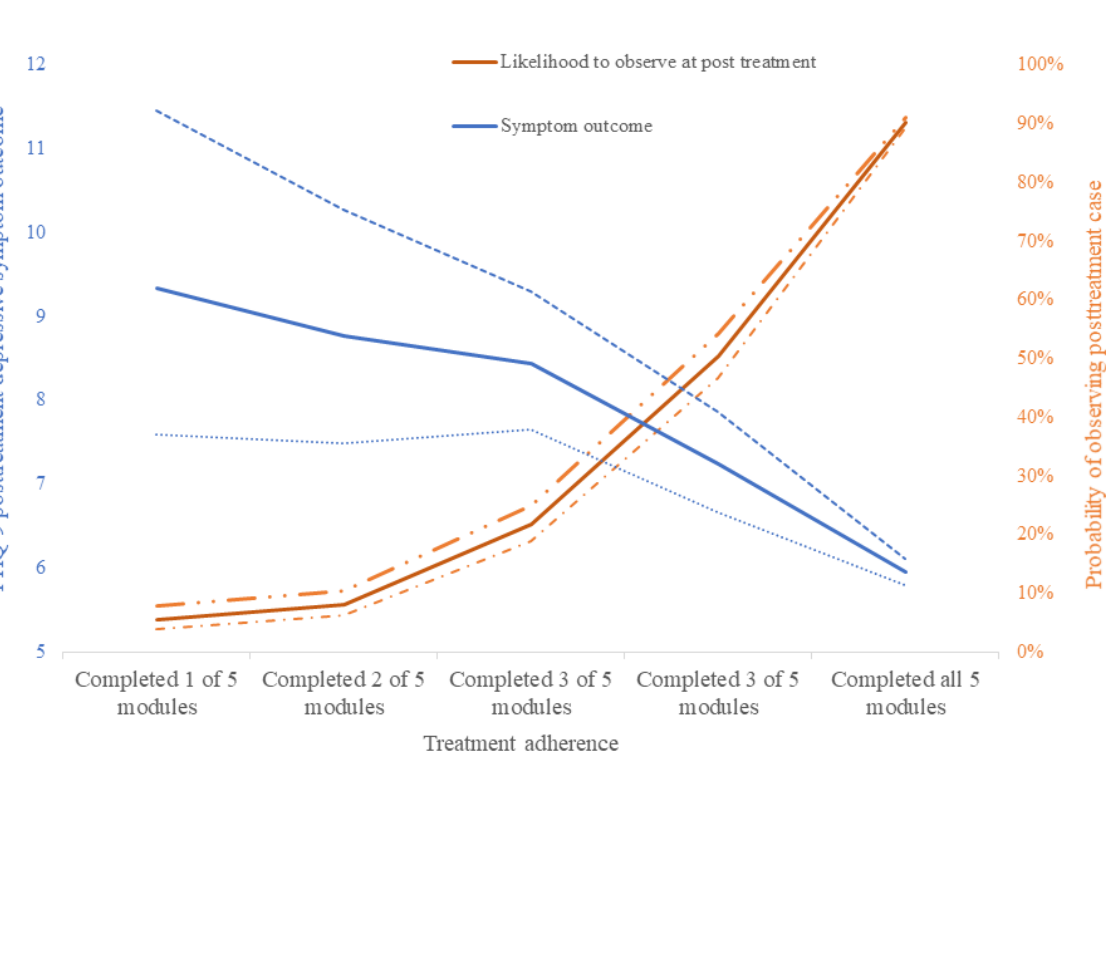
Table 7, showing treatment completion, baseline severity, and relationship status to significantly moderate changes in psychological distress.